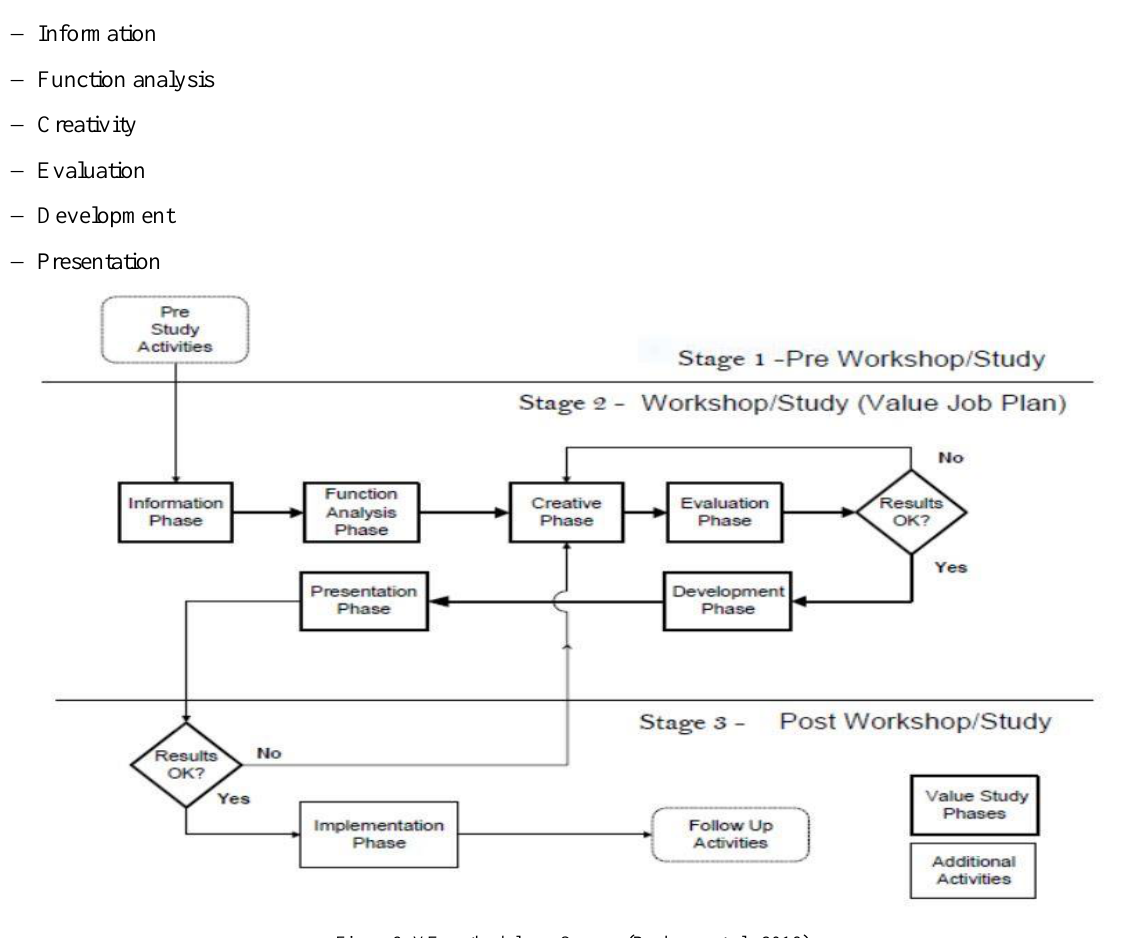
Figure 3: VE methodology. Source: (Rachwan et al.,